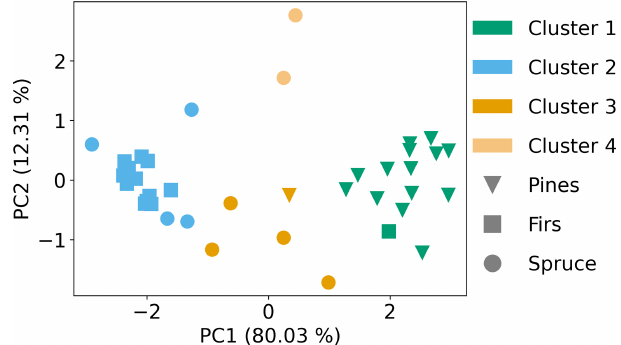
Figure 8. PCA coupled with k -means clustering results for the PC1 and PC4